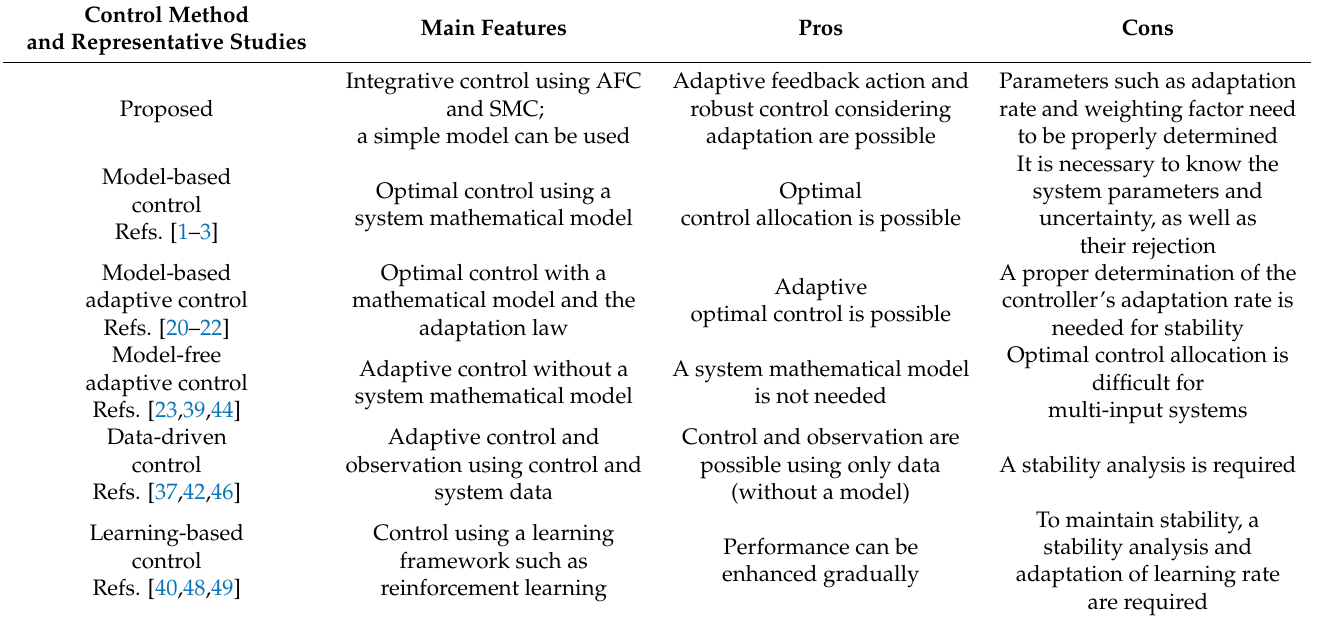
Table 1. A comparison of the pros and cons of several control